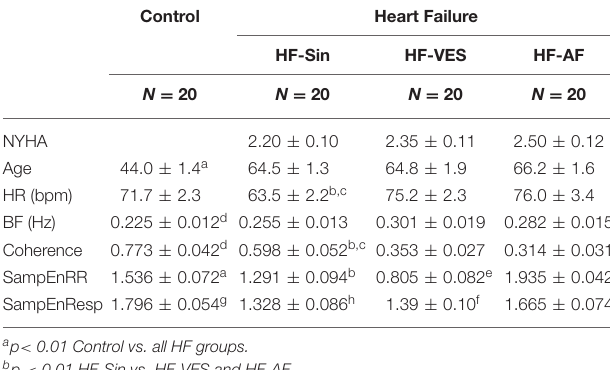
TABLE 1 | Cardiac and respiratory